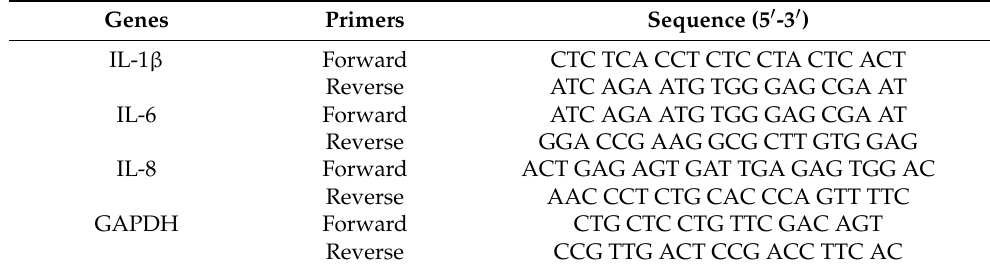
Table 1. Primer sequences for